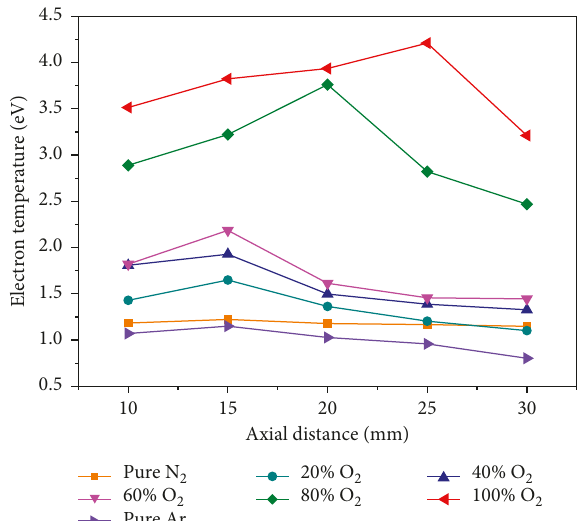
Figure 8: Axial spatial distribution of the electron temperature of the plasma jet.